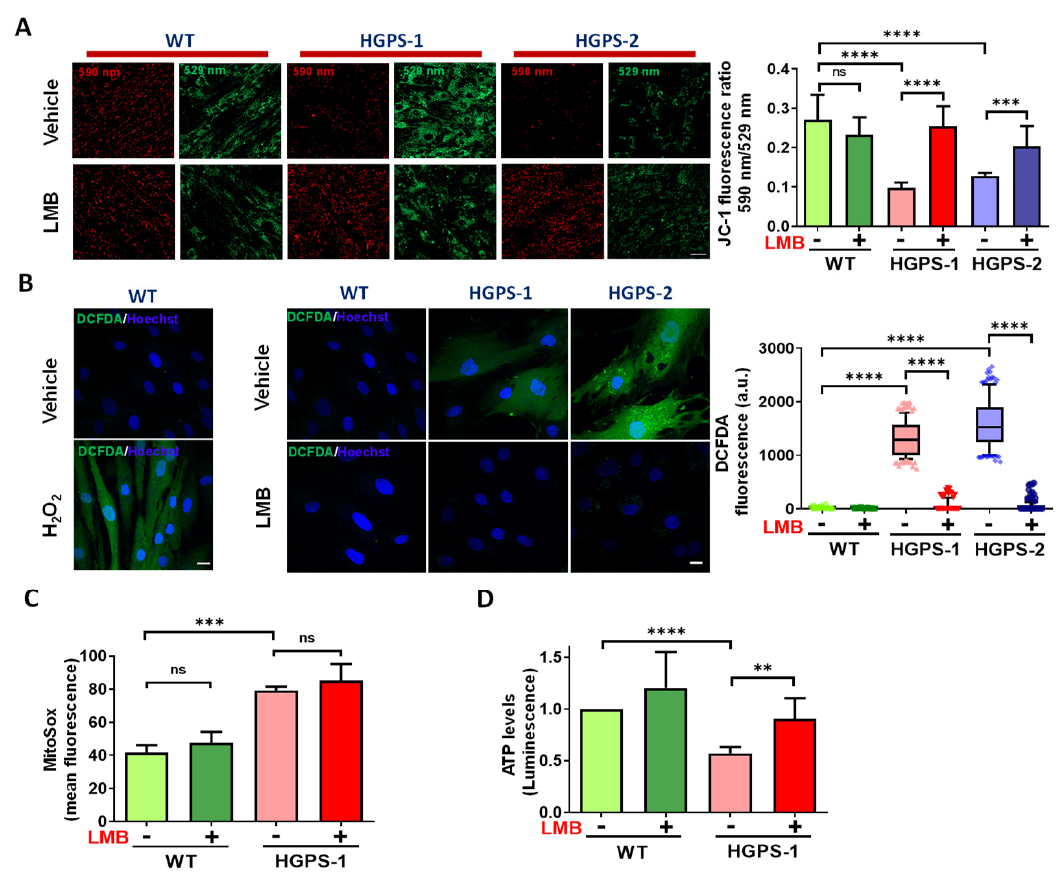
Figure 3. Mitochondrial function is restored in LMB-treated HGPS fibroblasts. ( A ) ∆ Ψ m of WT and HGPS cells was analyzed using JC-1 dye staining and confocal microscopy analysis. Left . WT and HGPS1-2 cells previously treated with 1 nM LMB (+) or the vehicle alone ( − ) for 3 days were stained with JC-1. Typical images of JC-1-stained cells are shown; scale bar, 50 µ m. Right , ∆Ψ m was calculated by the 590 nm/529 nm fluorescence intensity ratio. Data corresponds to the mean +/ − SD of three independent experiments (n ≈ 120 cells per condition), with p values denoting significant differences (unpaired t test; *** p < 0.001; **** p < 0.0001). ( B ) Left . The generation of intracellular ROS was measured in WT cells incubated with H 2 O 2 or its vehicle alone using the H2DCFDA-based assay and confocal microscopy analysis. Nuclei were stained with Hoechst. Middle . WT and HGPS1-2 cells were treated with LMB (+) or the vehicle alone ( − ), as in panel A, prior to being incubated with H2DCFDA to detect ROS. Nuclei were visualized by staining with Hoechst and typical images of H2DCFDA-stained cells are shown. Scale bar, 10 µm. Right . Variation in H2DCFDA fluorescence intensity between the experimental groups was determined using Image J (see Methods for details).